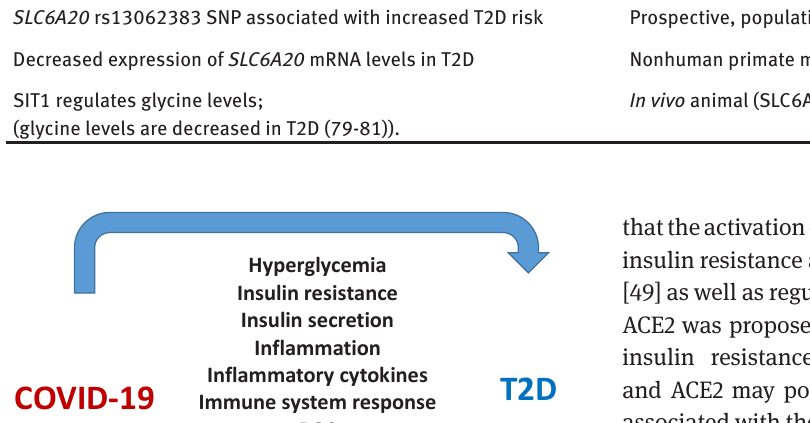
Table 2: Relevant publications dealing with association of SLC6A20 / SIT1 with Type 2 Diabetes (T2D). SIT1 association with T2D risk and traits Type of Study